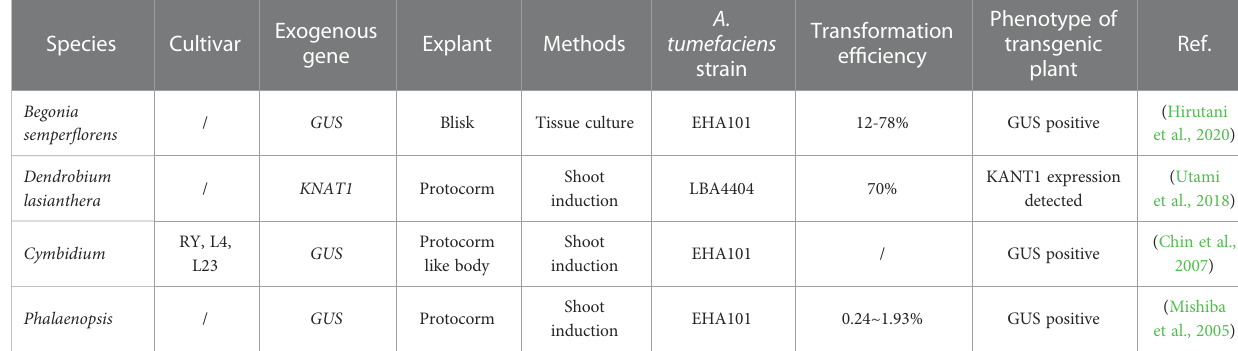
FIGL1 (FIDGETIN-LIKE-1) , HEI10 (HUMAN ENHANCER OF CELL INVASION NO.10) and HCR1 (HIGH CROSSOVER RATE1) (Crismani et al., 2012; Se ́ gue ́ la-Arnaud et al., 2015;